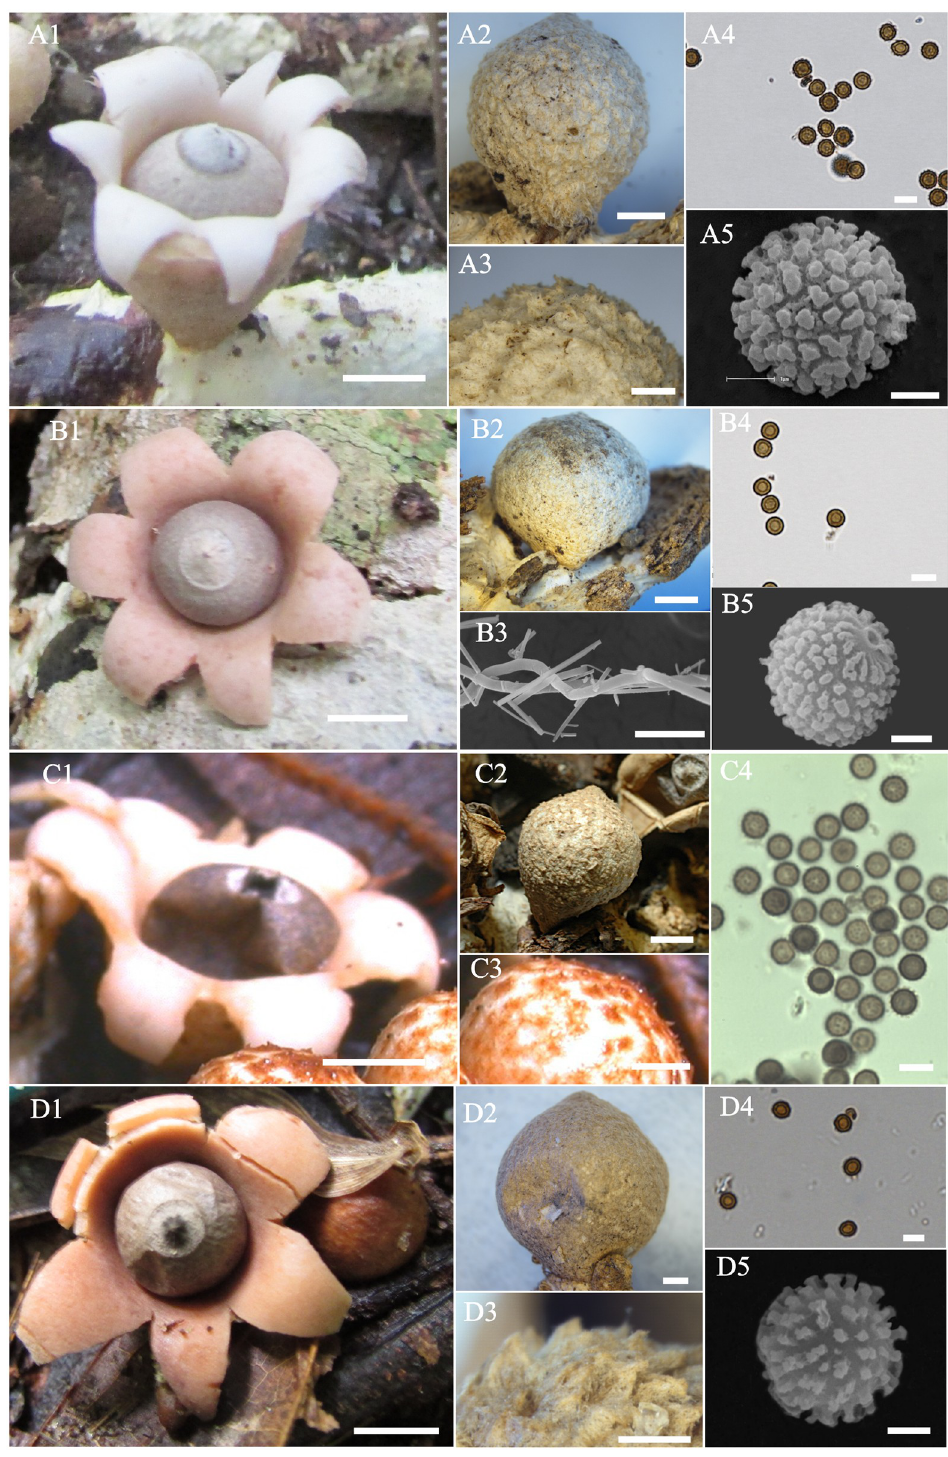
Fig 4. Geastrum schweinitzii and allies. (A). Geastrum neoamericanum sp. nov. (B) Geastrum baculicrystallum sp. nov. (C). Geastrum courtecuissei sp. nov. (D) Geastrum rubropusillum sp. nov. A1, B1, C1, D1 Expanded basidiomata. A2, B2, C2, D2 Unexpanded Basidiomata. A3, C3, D3 Exoperidium detail. B3. Rhizomorphs under SEM. A4, B4, C4, D4 Basidiospores under LM. A5, B5, D5 basidiospores under SEM. A1, B1, D1 bar = 5 mm; C1 bar = 3 mm; A2, B2, C2 bar = 2 mm; A3, D2 bar = 1 mm; A4, B3, C4, D4 bar = 5 μ m; A5, B5, D5 bar = 1 μ m.